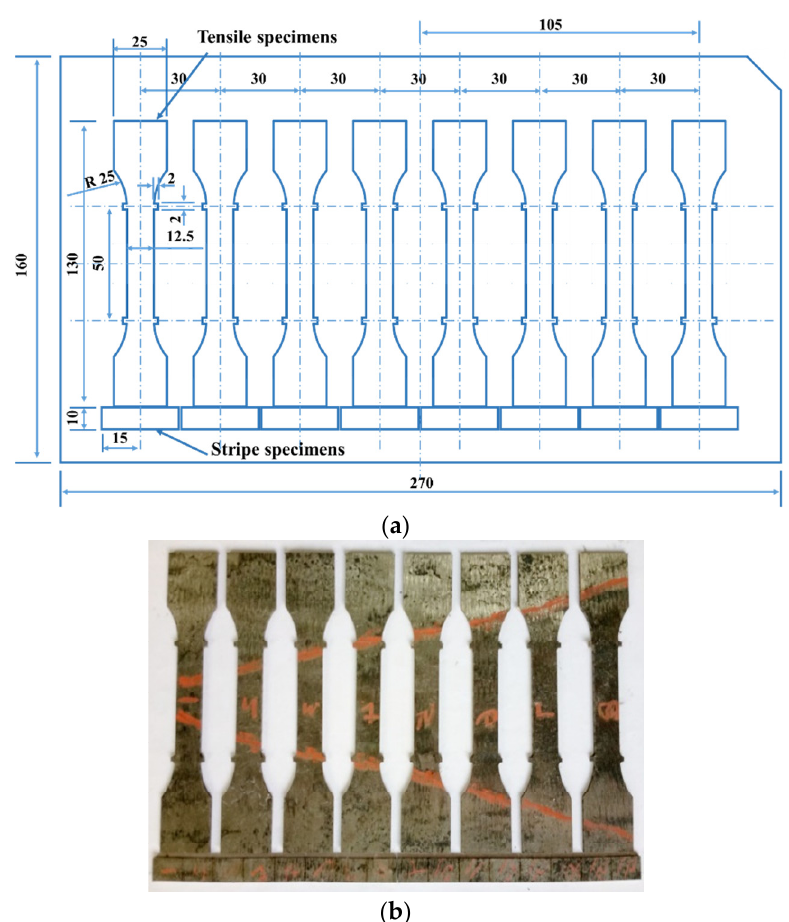
Figure 5. ( a ) Location and ( b ) entity of specimens.